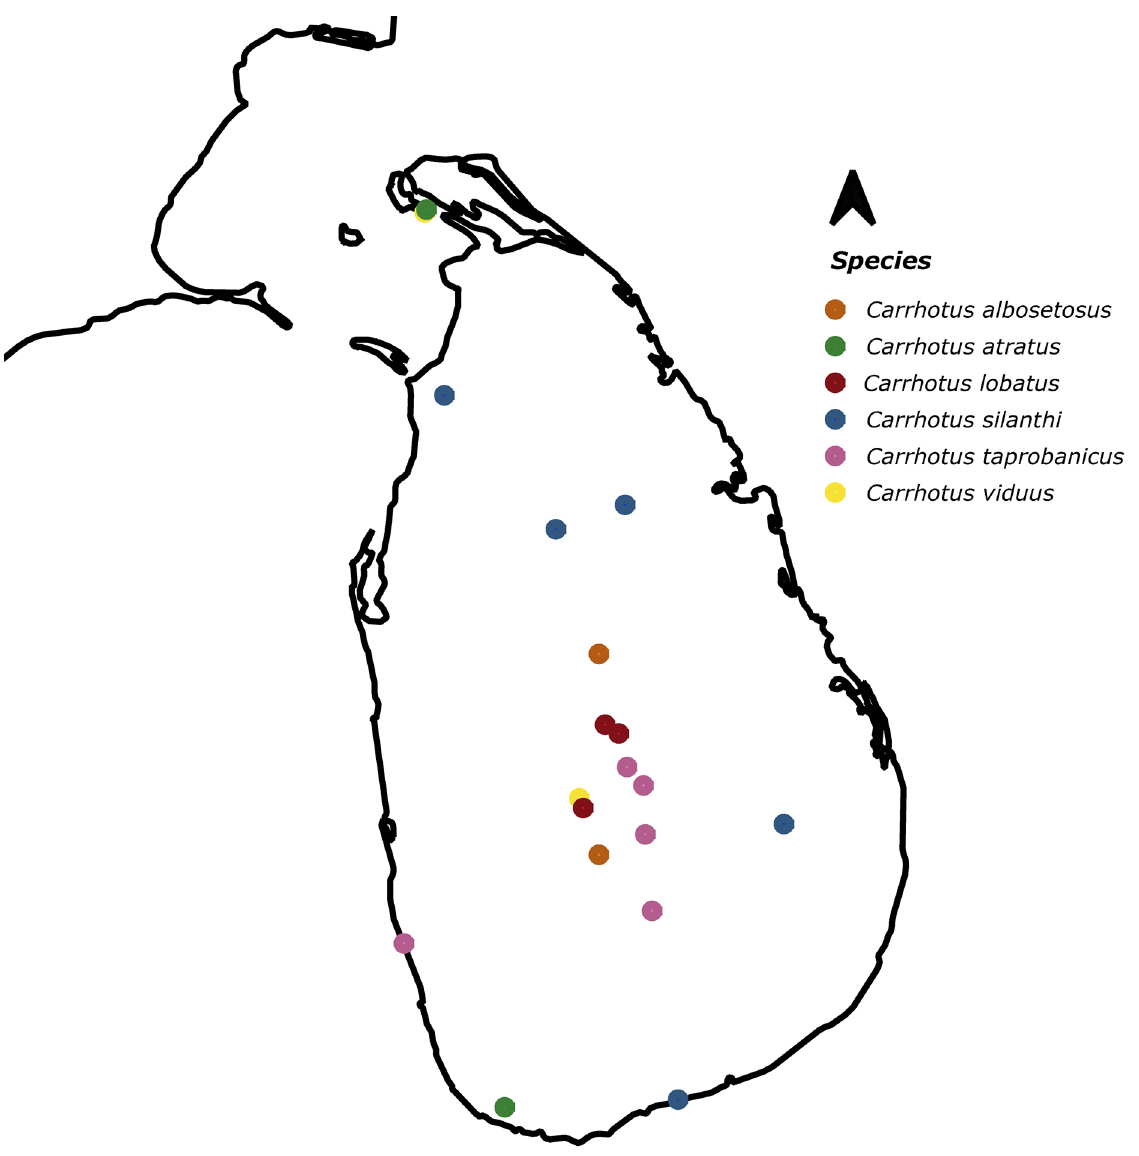
Fig 17. Distribution of Carrhotus spp. of Sri